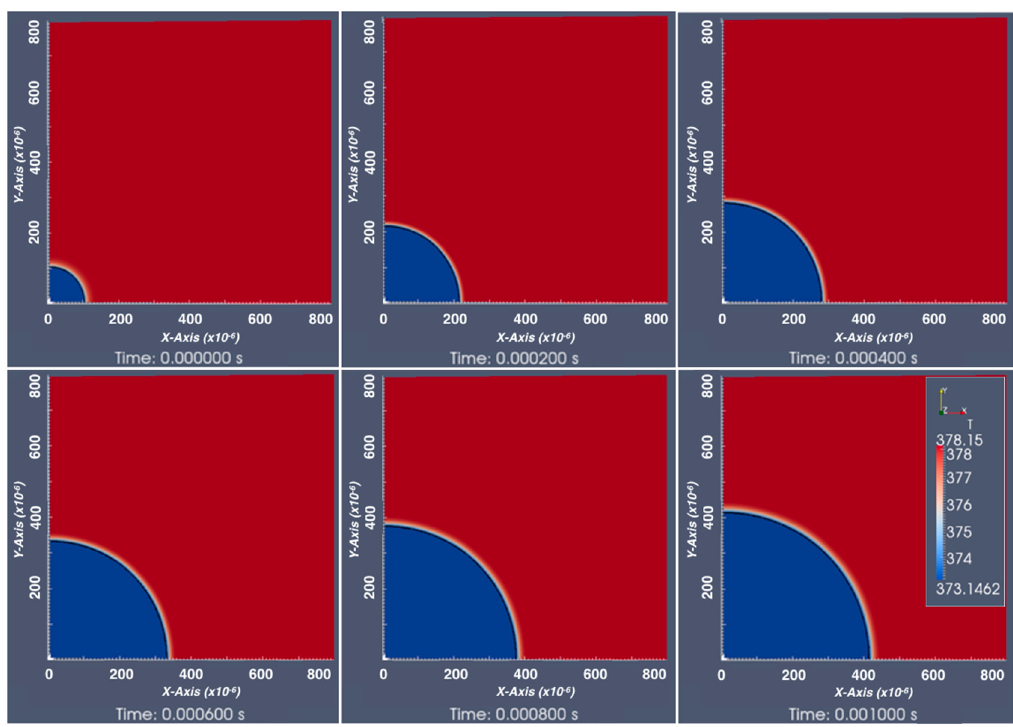
Figure 5. Bubble evolution with time for the water liquid/vapour simulation ( P = 1.013 bar, Δ T = 5 K). Energies 2017 , 10 , 272